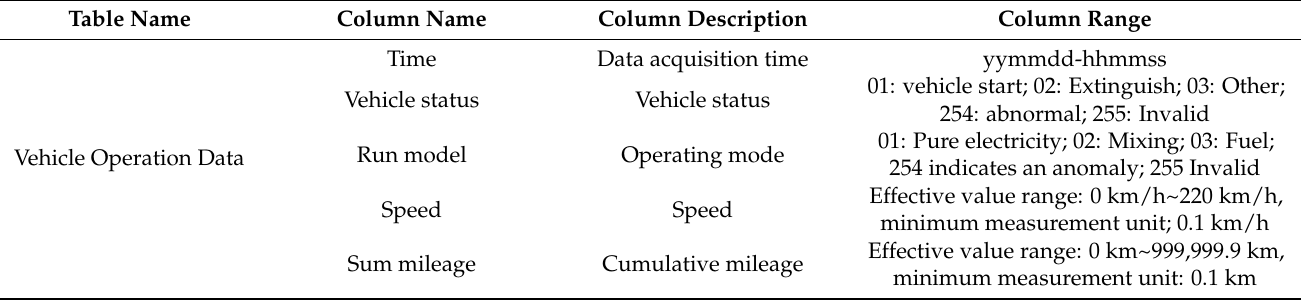
Table 1. Description of crawling data